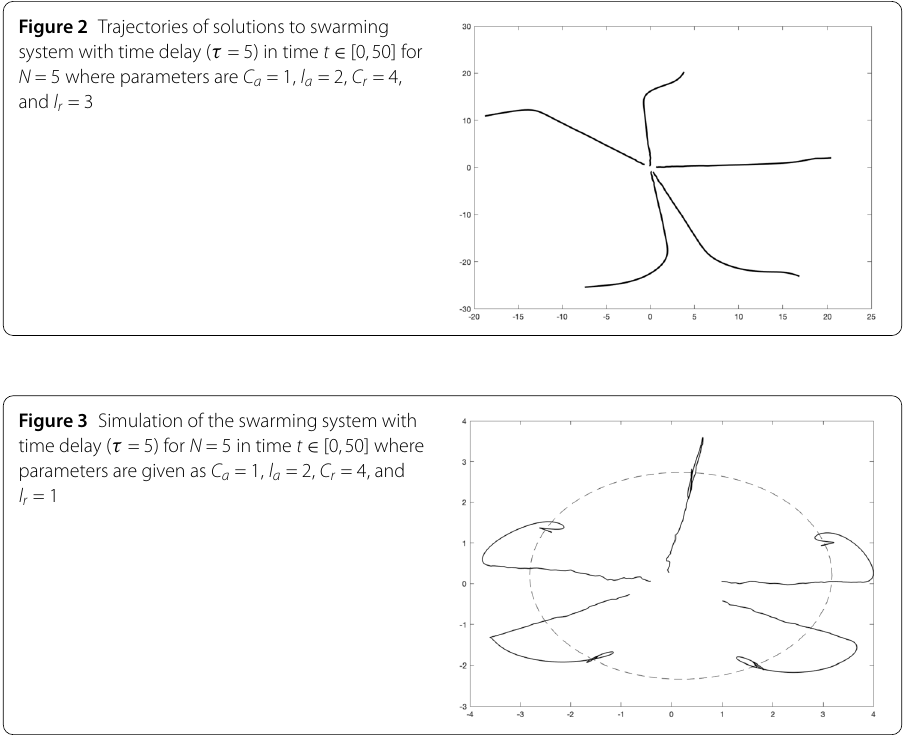
Figure 2 Trajectories of solutions to swarming system with time delay ( τ = 5) in time t ∈ [0,50] for N = 5 where parameters are C a = 1, l a = 2, C r = 4, and l